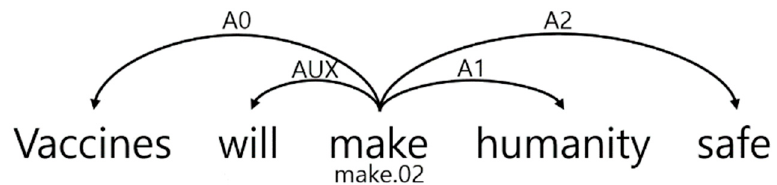
Figure 1. Example of a dependency-based SRL.